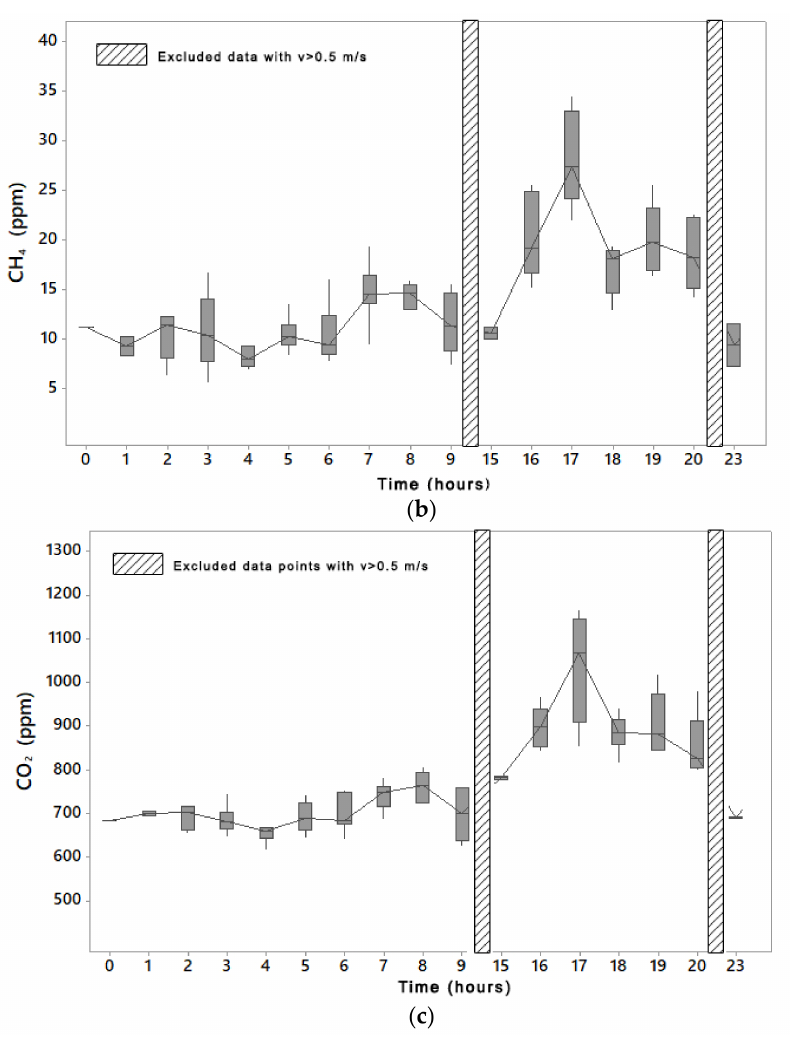
Figure 4. Daily trend of NH 3 ( a ), CH 4 ( b ), and CO 2 ( c ) concentrations, in the central SLs, at low air velocity (v ≤ 0.5 m s − 1 ) in W2.